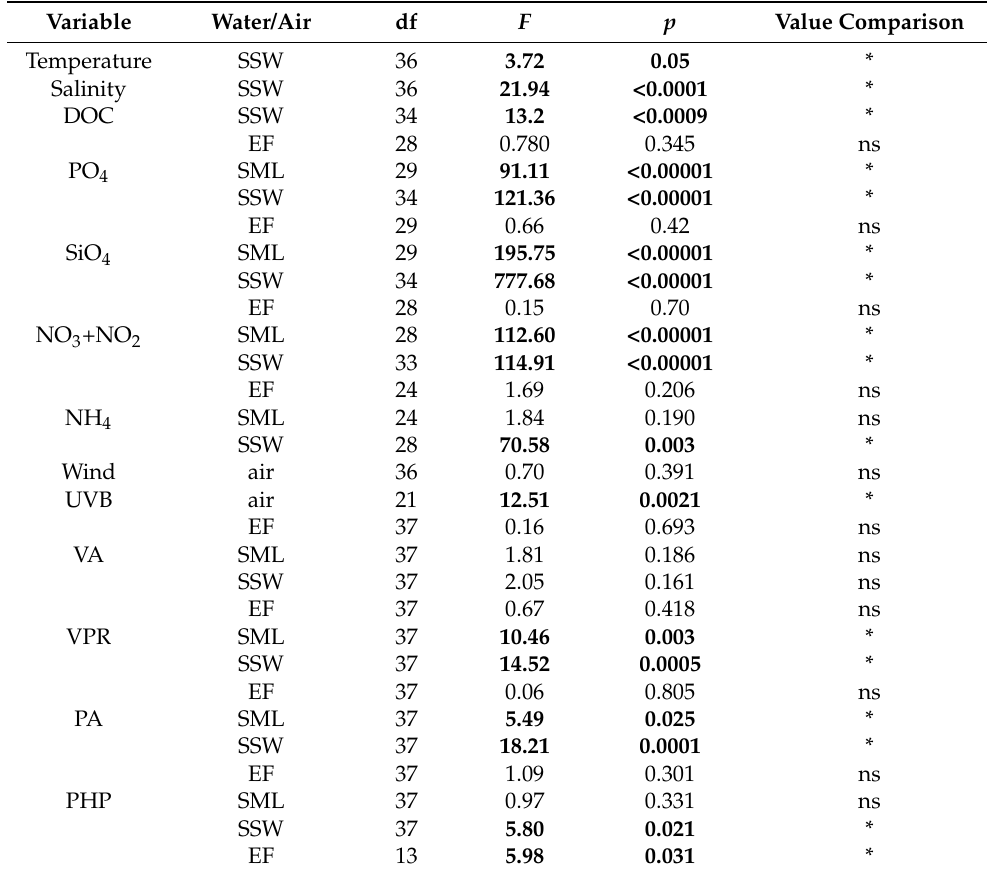
Table 4. ANOVA analysis for variables measured in the SML and SSW, as well as in the air between Arctic and Antarctic systems. df: degree of freedom; F : Fisher coefficient; p : significance level values in bold. * Significant higher values in Arctic than in Antarctic waters; * significant higher values in Antarctic than in Arctic waters. ns: no significant values. For variable acronyms and units, see Tables 1 and